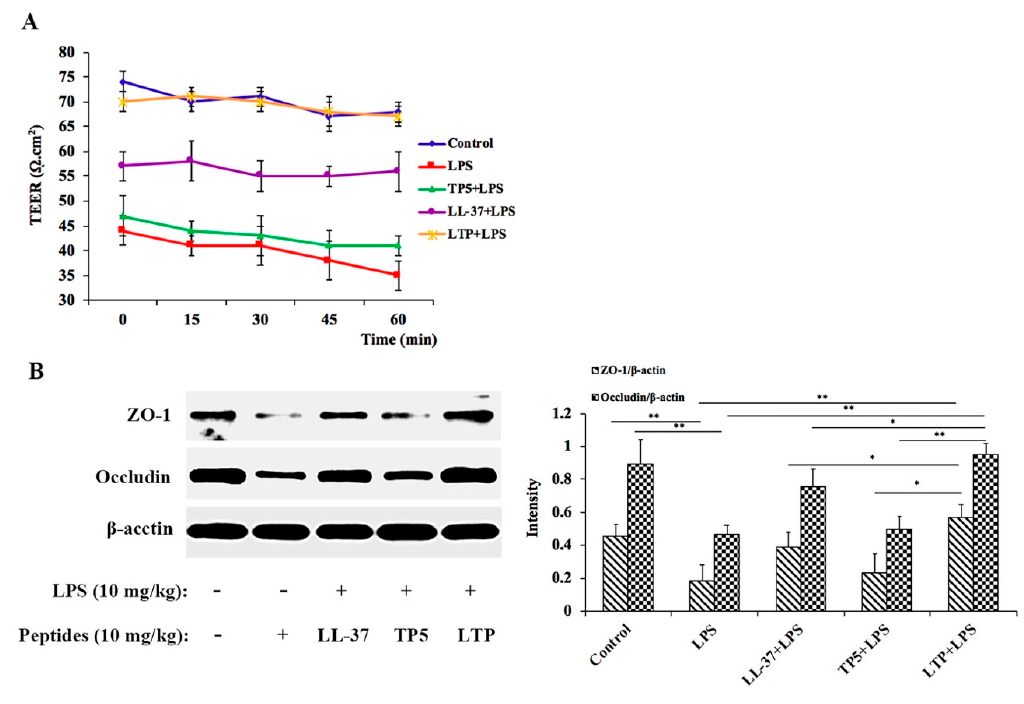
Figure 5. The protective effects of LTP on the inflammatory response. After treatment with 10 mg/kg LPS in the presence or absence of peptides, protein levels of TNF- α ( A ), IFN- γ ( B ), and IL-6 ( C ) in mouse jejunum tissue were quantified by ELISA. (D) Representative images of CD177+. Bar, 50 μ m. ( D - a ) control, ( D - b ) LPS, ( D - c ) LL-37 + LPS, ( D - d ) TP5 + LPS, and ( D - e ) LTP + LPS. ( E ) Enzymatic activities of MPO. Data are presented as the mean value ± standard error from 12 biological